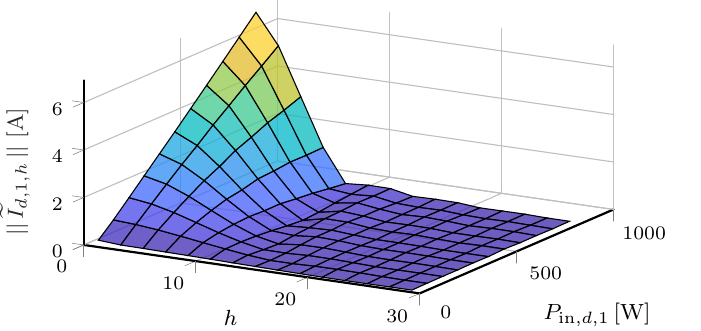
Figure 9. Contour plot of the current magnitude of the measured nonlinear device as a function of harmonic number and input power.